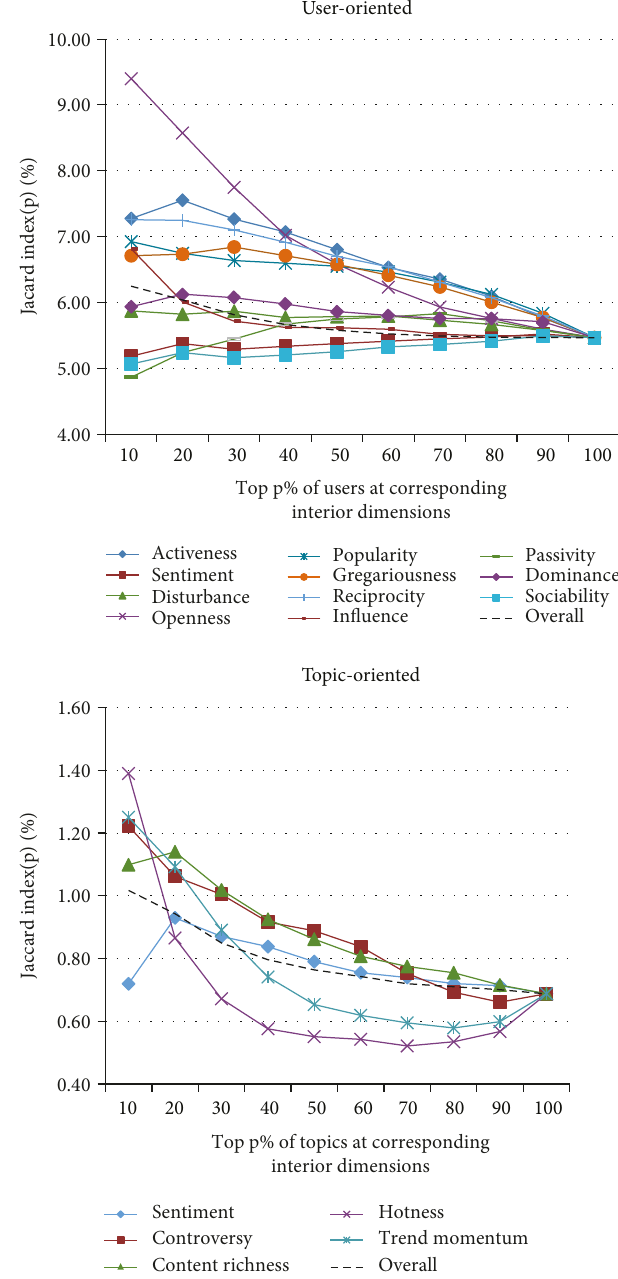
Figure 5: Overlapping in neighborhood selection. (a) Overlap between user interior dimension-based ( Ngbr U ( Ngbr U ) neighbor selection; (b) overlap between topic interior dimension-based ( Ngbr T Corr neighbor